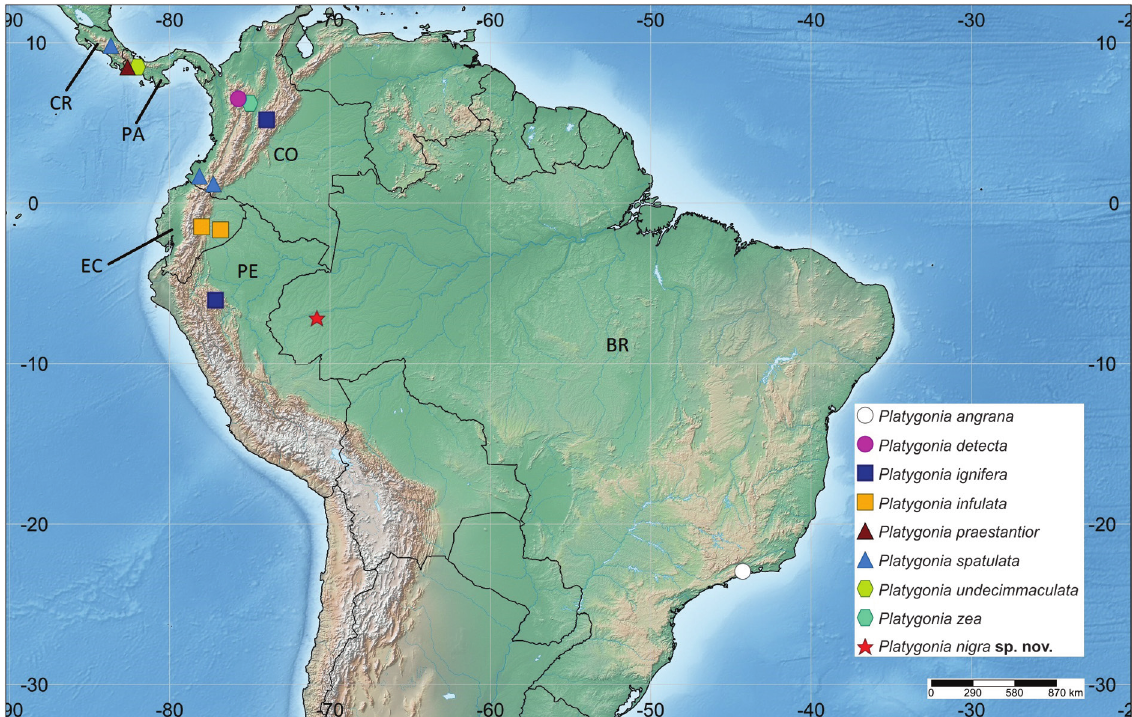
Fig. 9. Known distribution of species of Platygonia Melichar, 1925. Countries: BR = Brazil; CO = Colombia; CR = Costa Rica; EC = Ecuador; PA = Panama; PE =